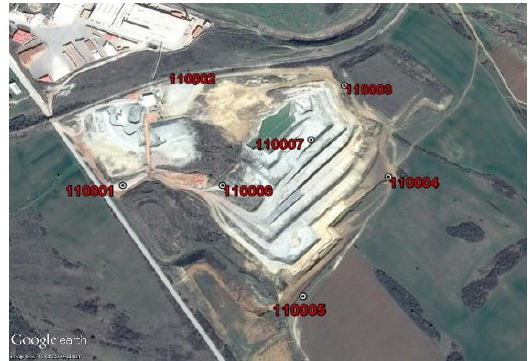
Figure 5. GCP distribution, image Google